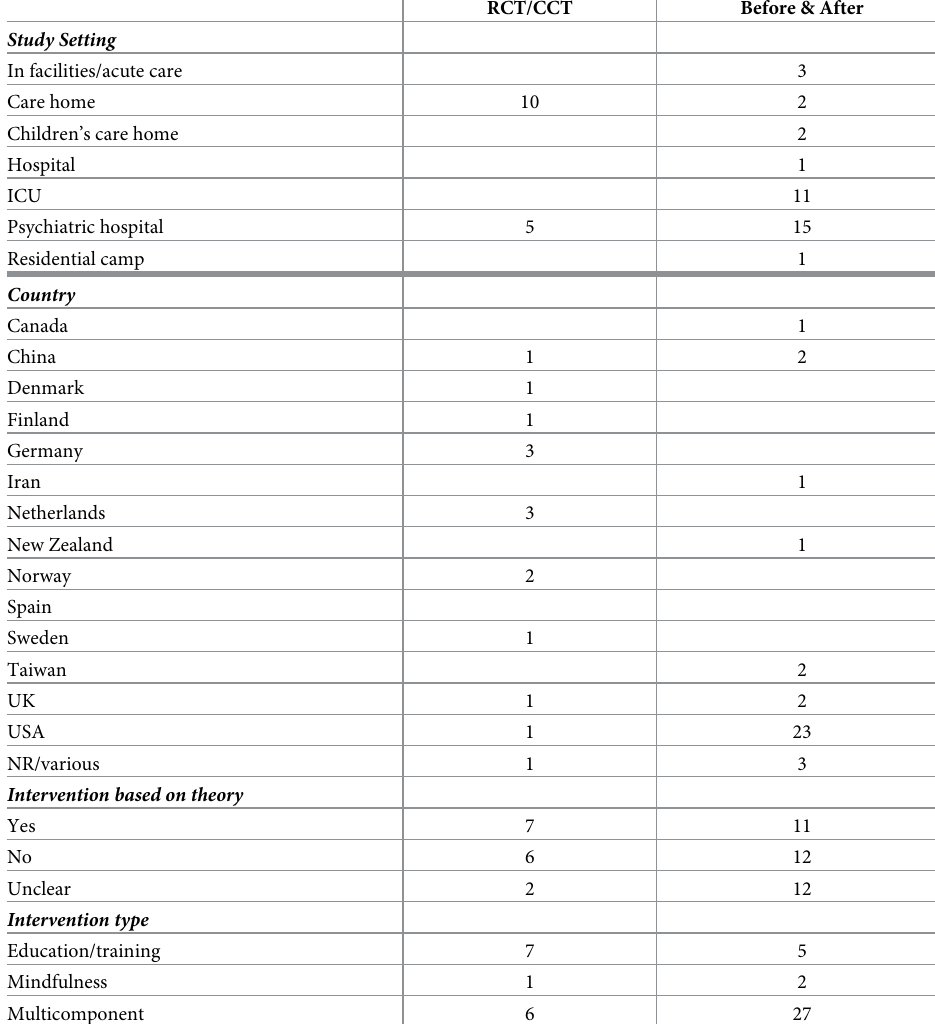
Table 3. Summary of characteristics of included primary non maternity intervention